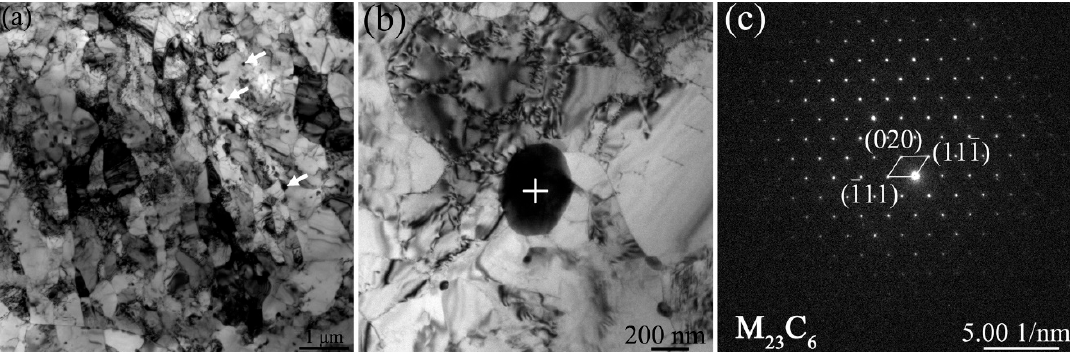
Figure 6. Typical weld metal TEM analysis of the joints obtained with PWHT at 730 °C for 2 h: ( a ) TEM images, ( b ) precipitates images, and ( c ) diffraction patterns of precipitate. The white arrows highlight the precipitates.